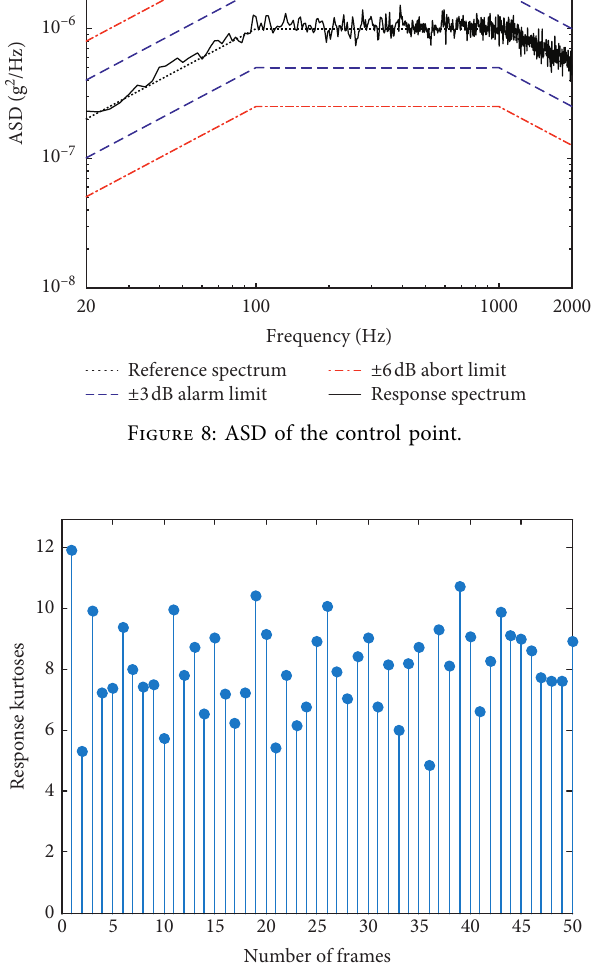
Figure 9: Kurtoses of all 50 frames of the